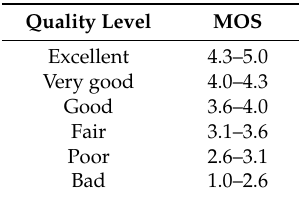
Table 2. MOS rating